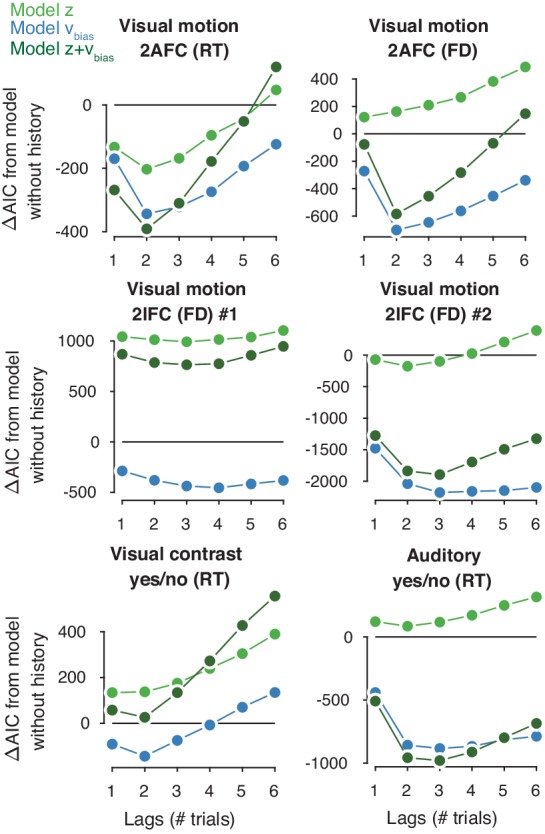
Contribution of previous choices to current drift and starting point bias as function of lag.Model comparison (ΔAIC from a baseline model without history) between models where previous correct and incorrect choices affected only starting point (light green squares), only drift bias (blue diamonds), or both (blue-green circles), up to six past trials. The best-fitting model is indicated by a black outline.